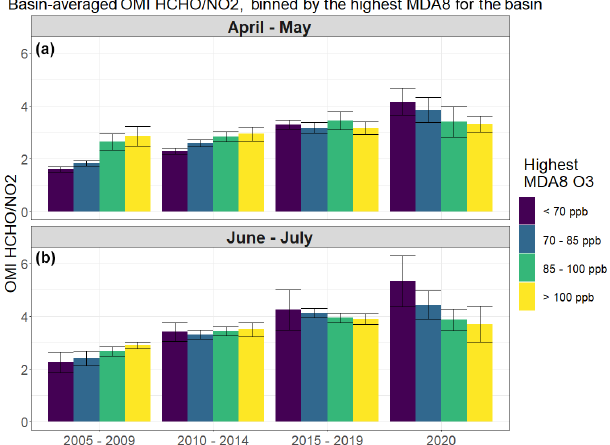
Figure 6. Time series of the basin-averaged OMI HCHO / NO 2 ra- tios. Data are binned every 5 years and are colored by the high- est MDA8 observed for the basin on each day. Each bar represents the mean ± 1 standard deviation. Panel (a) shows data from spring (April–May), and panel (b) shows data from summer (June–July).